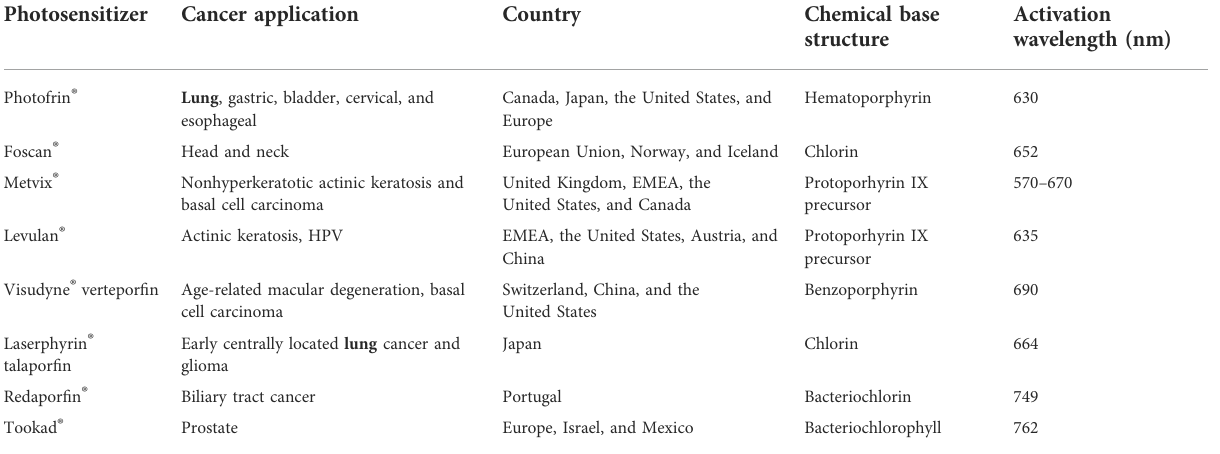
TABLE 1 Clinically approved